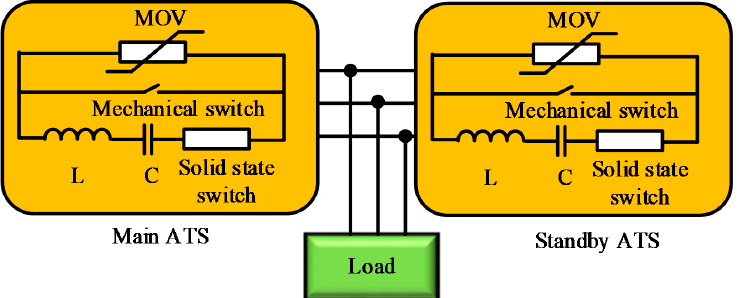
Figure 5. System scheme of ATS [1].